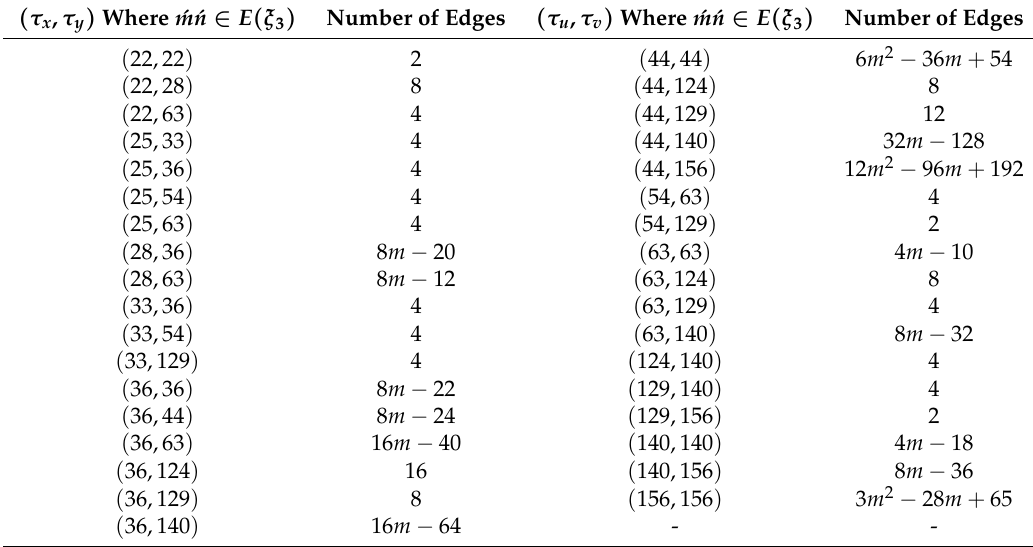
Table 6. Edge partition of the third type of rectangular hex-derived network RHDN 3 ( m ) based on the sum of degrees of end vertices of each